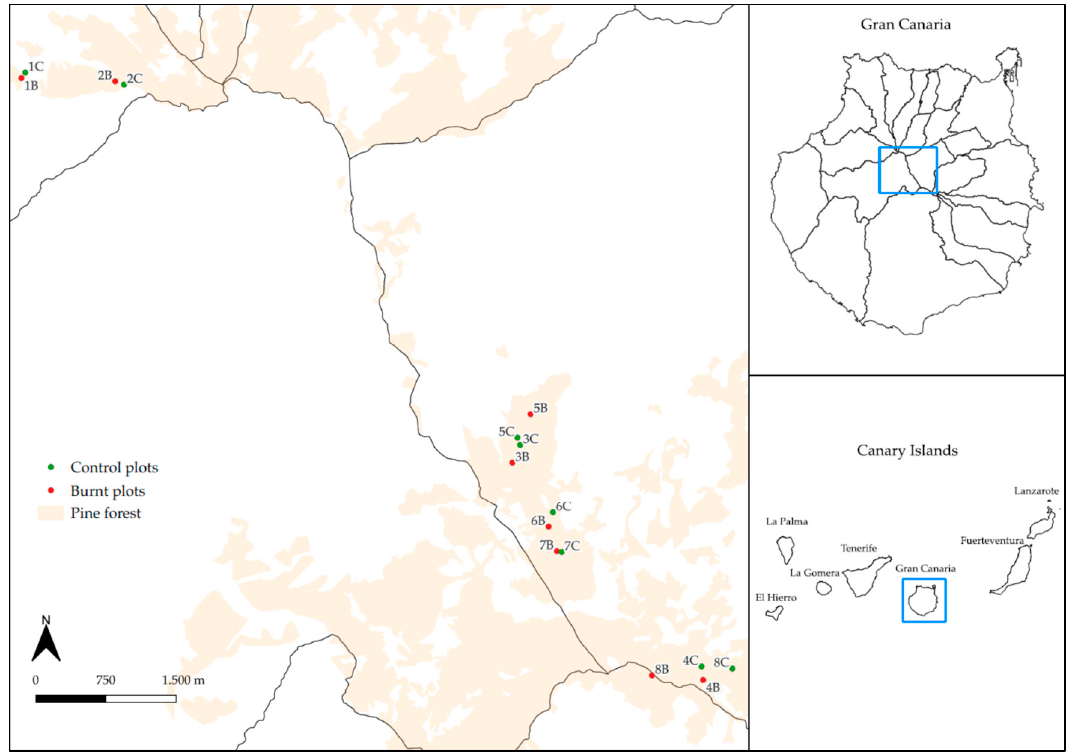
Figure 1. The Canary Islands archipelago, Gran Canaria Island and plot location (red for burned (B) plots and green for control (C) plots). The distribution of the pine forest is in shadow. Table 1. Site description, cover type and years from the last prescribed burning. Altitude Slope Aspect Rock Litter Herbs Litter Depth Plot (m) ( ◦ Sex.) (% Cover)